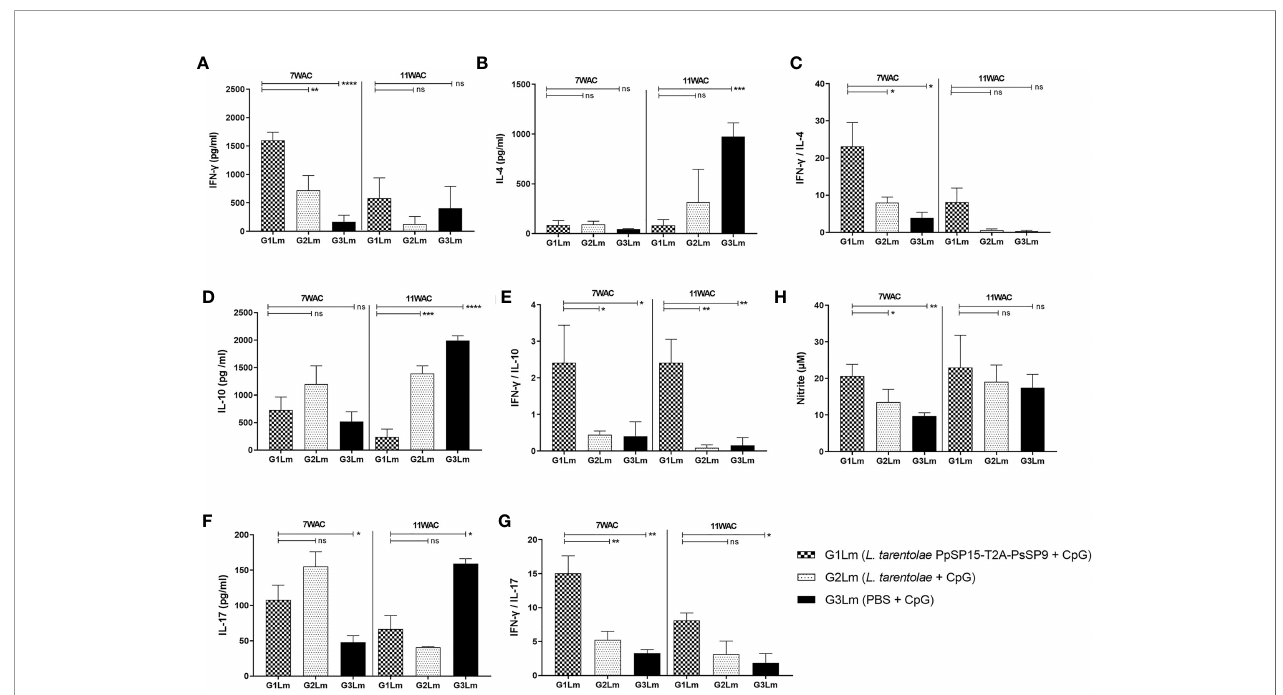
FIGURE 5 | Analysis of cytokines production in vaccinated and control mice post-infection with L. major +SGH Ph. papatasi . Following 7 th and 11 th weeks after challenge, all mice (n=3-4 per group) were sacri fi ced and single splenocytes from each individual BALB/c mouse were re-stimulated by L. major F/T antigen. (A) IFN- g production, (B) IL-4 production, (C) IFN- g /IL-4 ratio, (D) IL-10 production, (E) IFN- g /IL-10 ratio, (F) IL-17 production, (G) IFN- g /IL-17 ratio, (H) Nitric oxide (NO) production. The results are presented as mean ± SE in pg/ml for cytokines or in µm for NO. Data are representative of two independent experiments. Student t-test was used for statistical analysis (* p < 0.05; ** p < 0.01; *** p < 0.001, **** p < 0.0001; ns, non-signi fi